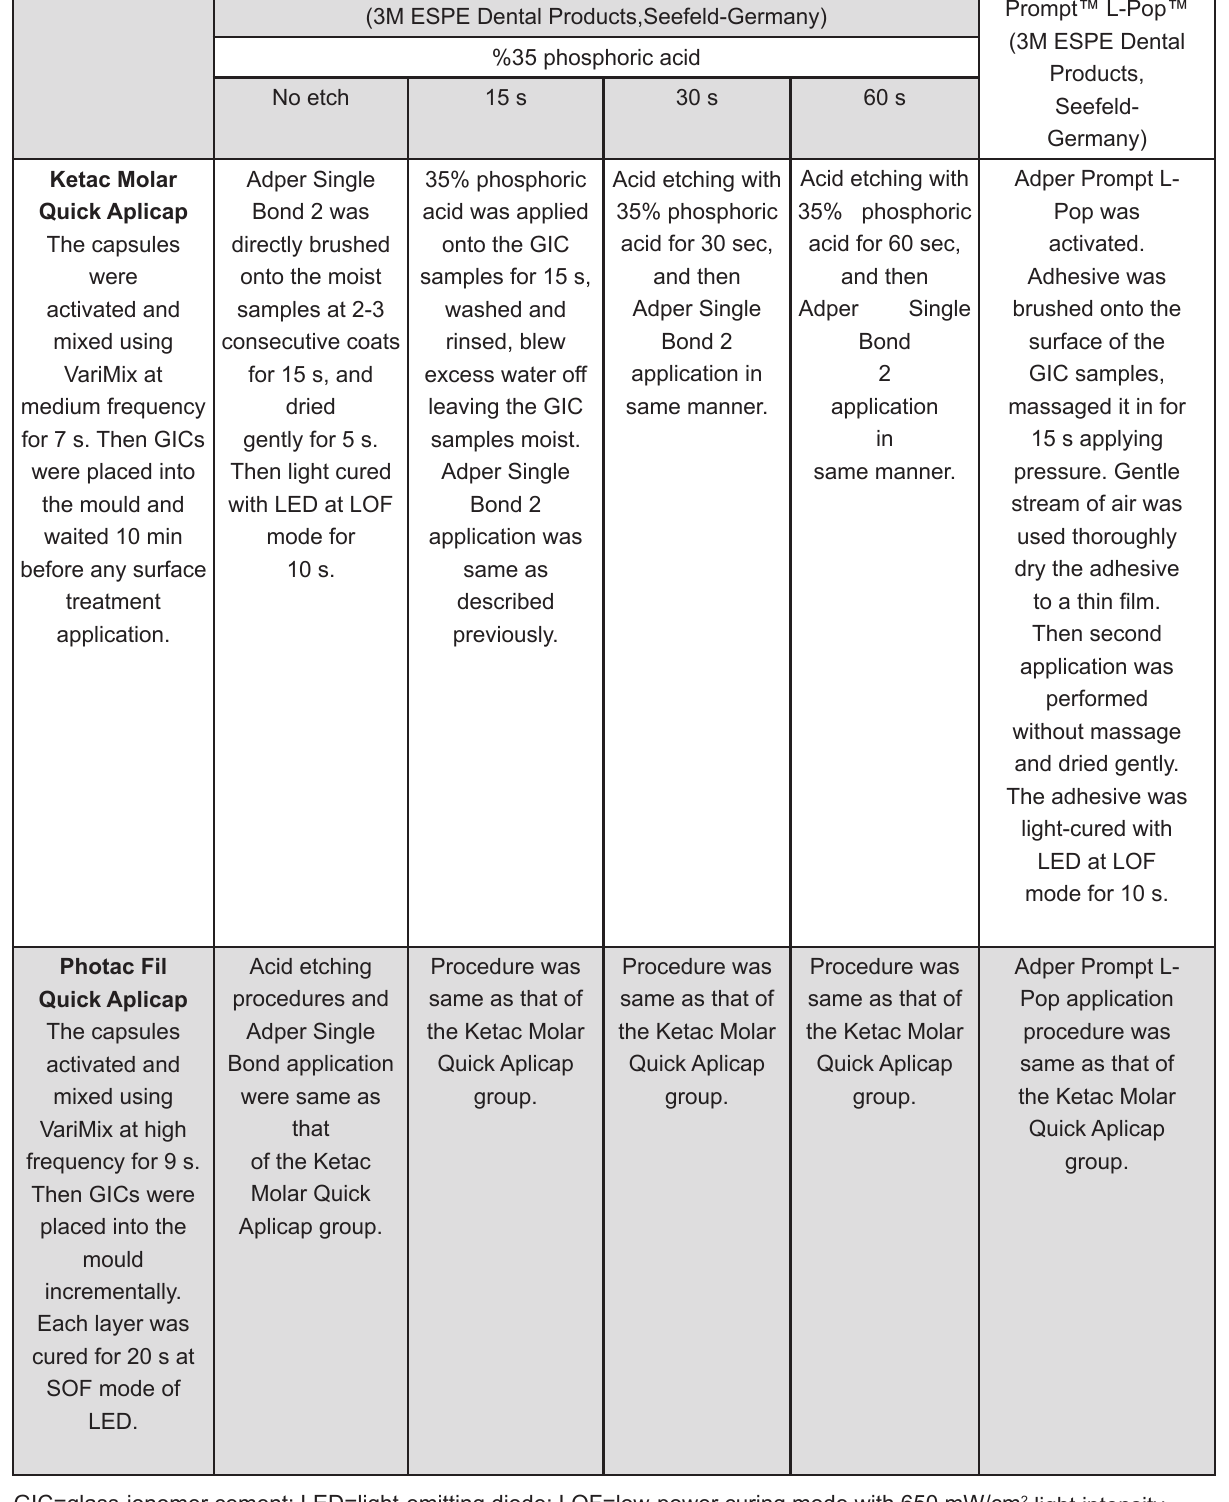
Figure 1- Experimental design and surface treatment modalities of GIC